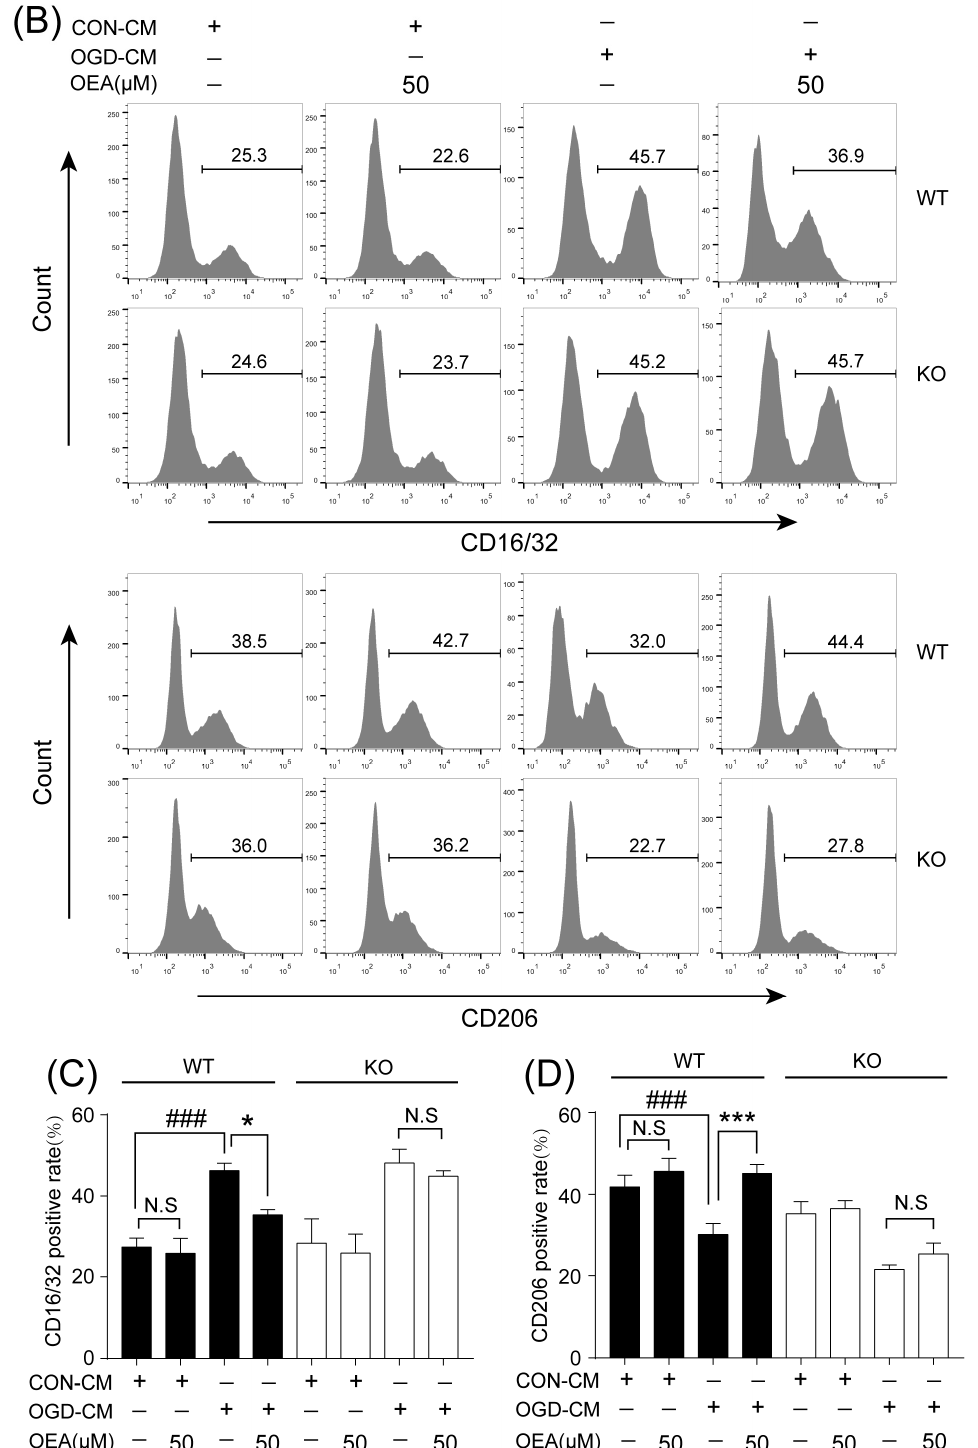
Figure 7. OEA shifts ischemic neuron-induced primary microglia polarization toward the M2 phenotype through PPAR α . ( A ) In vitro experimental design. ( B – D ) Representative FACS panels and quantification showing that OEA promoted the M1-M2 switch in WT microglia, while it had no impact on the M1-M2 switch in KO microglia. The data are presented as the mean ± SEM. n = 5. Each experiment was repeated three times. ### p < 0.001 vs. CON-neuron medium super- natant (CM) group. * p < 0.05, *** p < 0.001 vs. oxygen-glucose deprivation (OGD)-CM group; N.S = No